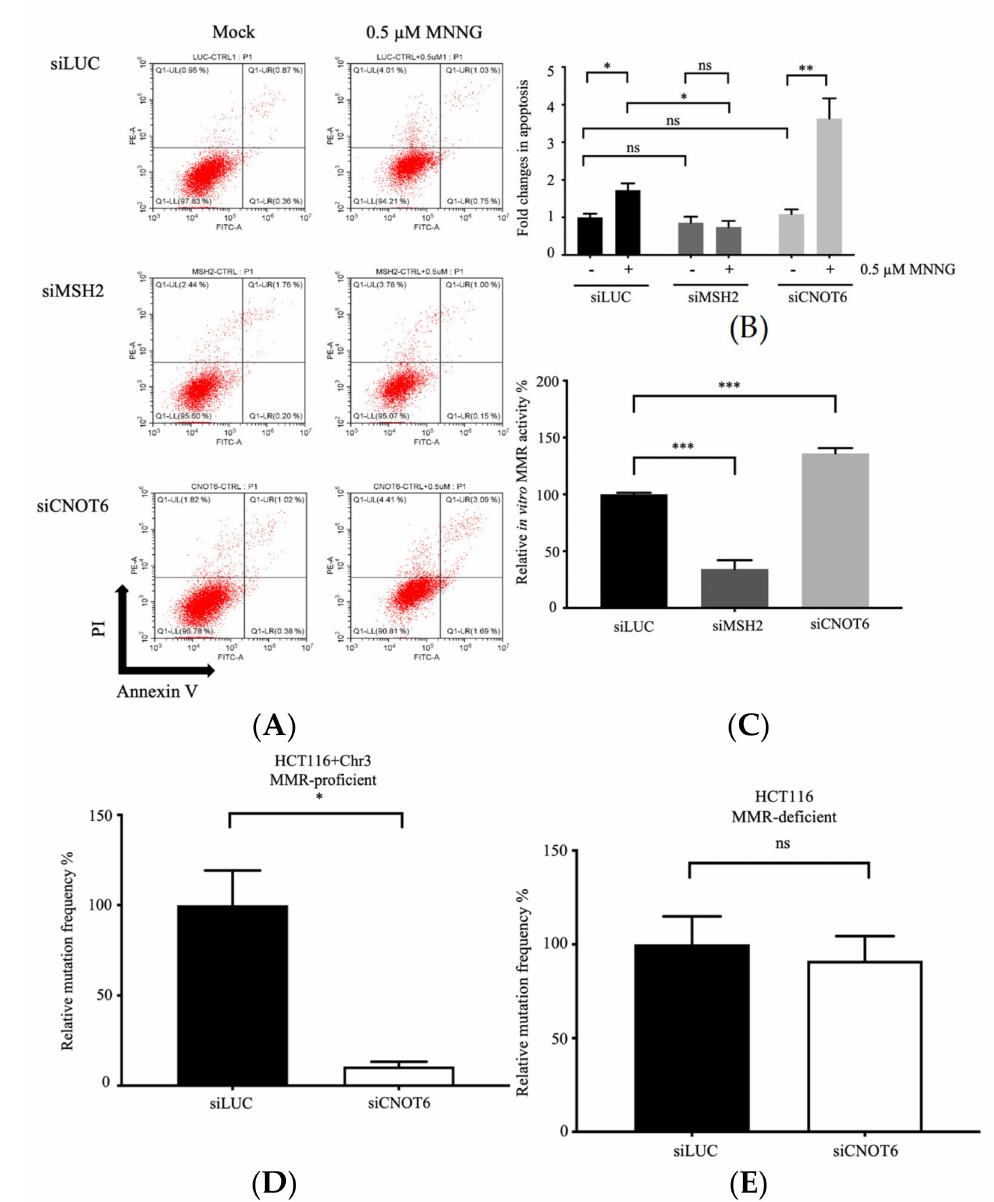
Figure 2. Depletion of CNOT6 increases apoptosis after exposure to MNNG, stimulates MMR and reduces mutation frequency in MMR-proficient cells. ( A ) Representative scatter plots of PI vs. Annexin V staining of U2OS cells transfected with siRNA targeting LUC, MSH2 or CNOT6 and treated with or without 0.5 µ M MNNG as described in Materials and Methods. ( B ) Quantification of flow cytometry data. Data are shown as mean ± SEM, n = 3; “ns” signifies “not significant”, * p < 0.5, ** p < 0.01, using unpaired two-tailed Student’s t test. ( C ) MMR activity in extracts from MSH2-depleted or CNOT6-depleted or control siLUC-treated U2OS cells. MMR was quantified using in vitro MMR assay (see Materials and Methods). Data are shown as mean ± SEM, n = 3; Statistical significance (*** p < 0.001) was determined using unpaired two-tailed Student’s t test. ( D , E ) HPRT assay was used to estimate mutation frequency in CNOT6-depleted ( D ) HCT116 + Chr3 (MMR-proficient) and ( E ) HCT116 (MMR-deficient) cells. Data are shown as mean ± SEM, n = 3; statistical significance (* p < 0.5) was determined using unpaired two-tailed Student’s t